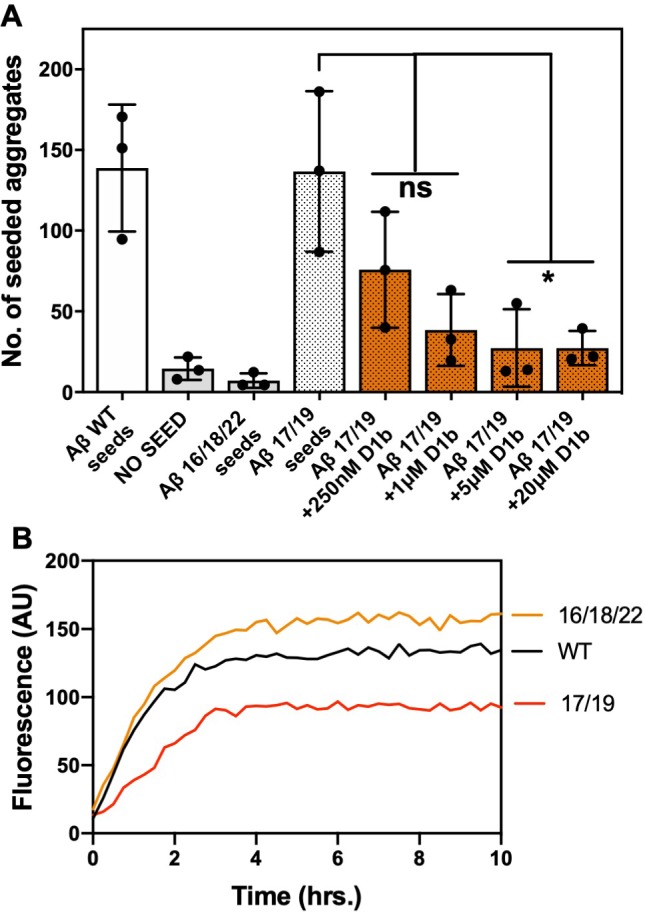
Seeding and inhibition of Aβ interface mutants.(A) Aβ interface mutant constructs form fibrils. 25 μM of each Aβ constructs was incubated under quiescent conditions at 37°C. Fibril formation was monitored using ThT fluorescence. Lines show the average of three technical replicates. (B) Average seeding by Aβ mutant constructs and effect of indicated inhibitor concentration. Error bars show the standard deviation of the mean of technical replicates (n = 3; ns = not significant; *, p<0.04 using an ordinary one-way ANOVA- Dunnett’s relative to Aβ 17/19 seeds).